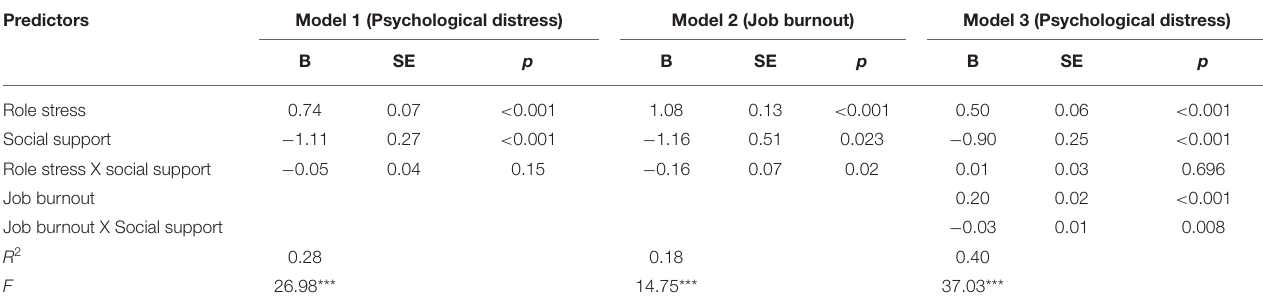
TABLE 3 | Testing the moderated mediation effect of social support on the relation between role stress and psychological distress via job burnout. Predictors